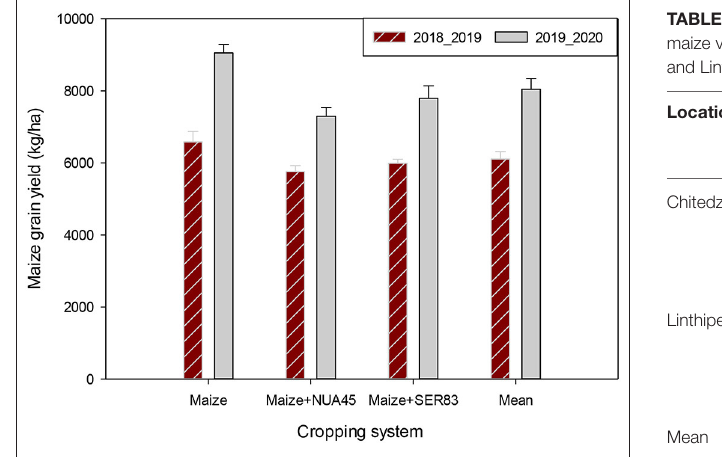
FIGURE 4 | Grain yield (kg/ha) of maize variety under sole and intercropping systems with newly released common bean varieties NUA45 and SER83 evaluated at Chitedze and Linthipe during 2018/2019 and 2019/2020 growing seasons.